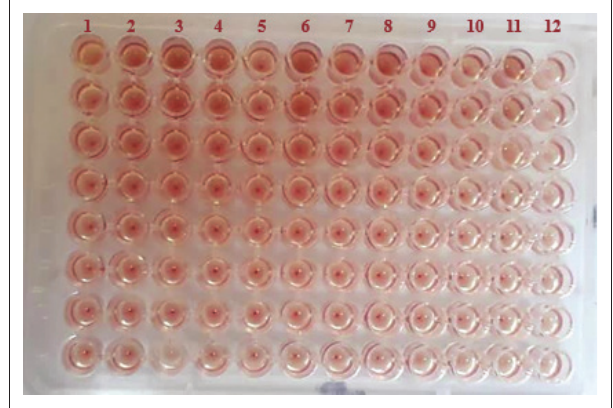
FIGURE 2: Haemagglutination test plate for detection of peste des petits ruminants virus antigen showing positive haemagglutination result as a diffused sheet or film and negative HA result as a sharp red button of sediment red blood cells. Peste des petits ruminants virus Control (Column 1), antigen samples (Columns 2–11), red blood cells control (Column 12). (Samples are in vertical position).